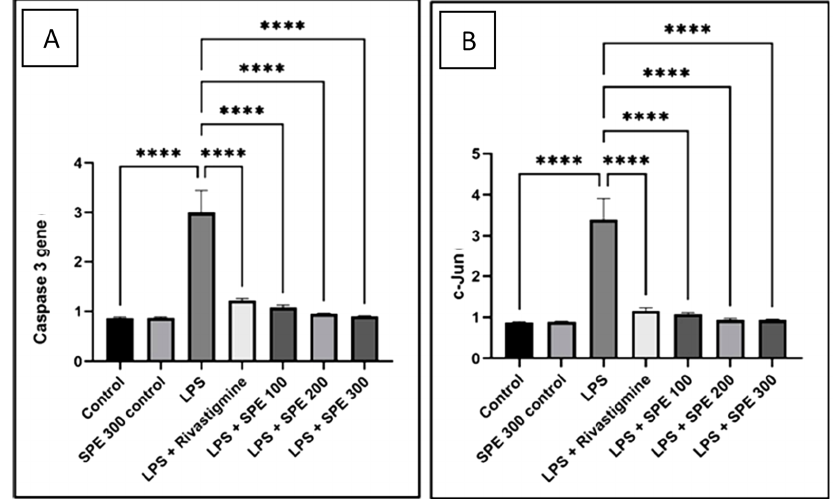
Figure 9. The relative gene expression of ( A ) caspase-3 and ( B ) c-Jun of the control (group 1), SPE 300 control (group 2), LPS (group 3), LPS + Rivastigmine (group 4), LPS + SPE 100 (group 5), LPS + SPE 200 (group 6), and LPS + SPE 300 (group 7). ****Significant at p ≤ 0.0001.